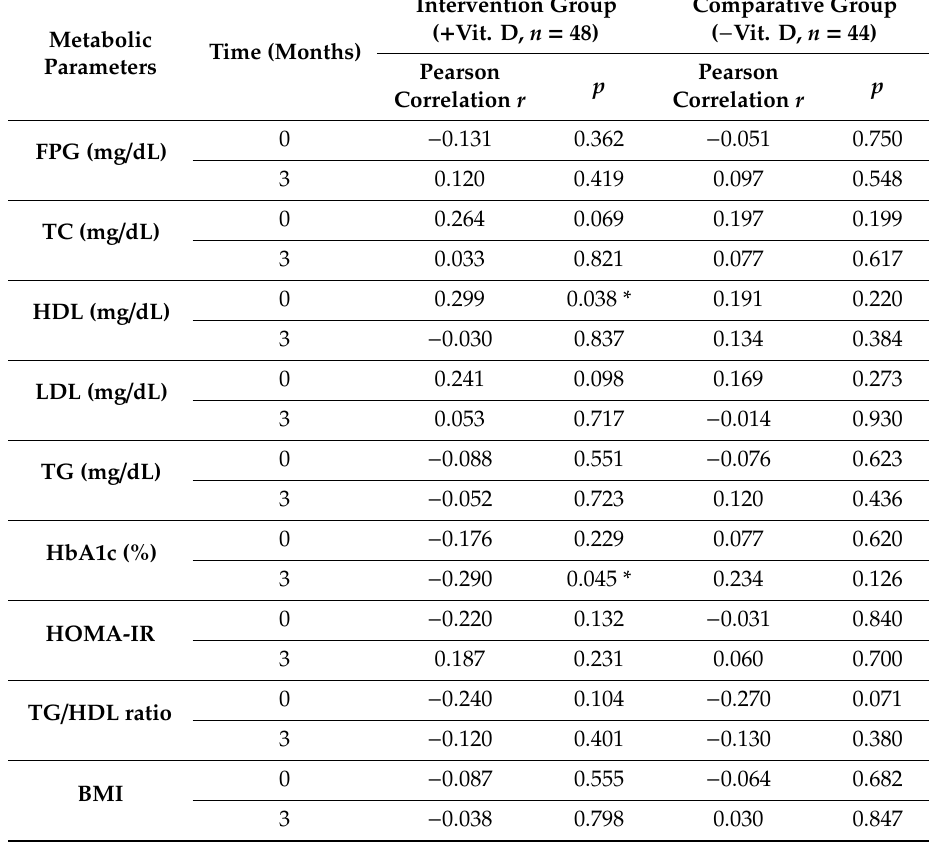
Table 6. The correlations between Vitamin D and metabolic parameters in the intervention group and comparative group at baseline and after three months of the study. The Pearson’s correlation test was employed, * denotes statistically significant correlation. Intervention Group Comparative Group ( + Vit. D, n = 48) ( − Vit. D, n = 44) Metabolic Time (Months) Parameters Pearson Pearson p Correlation Correlation r